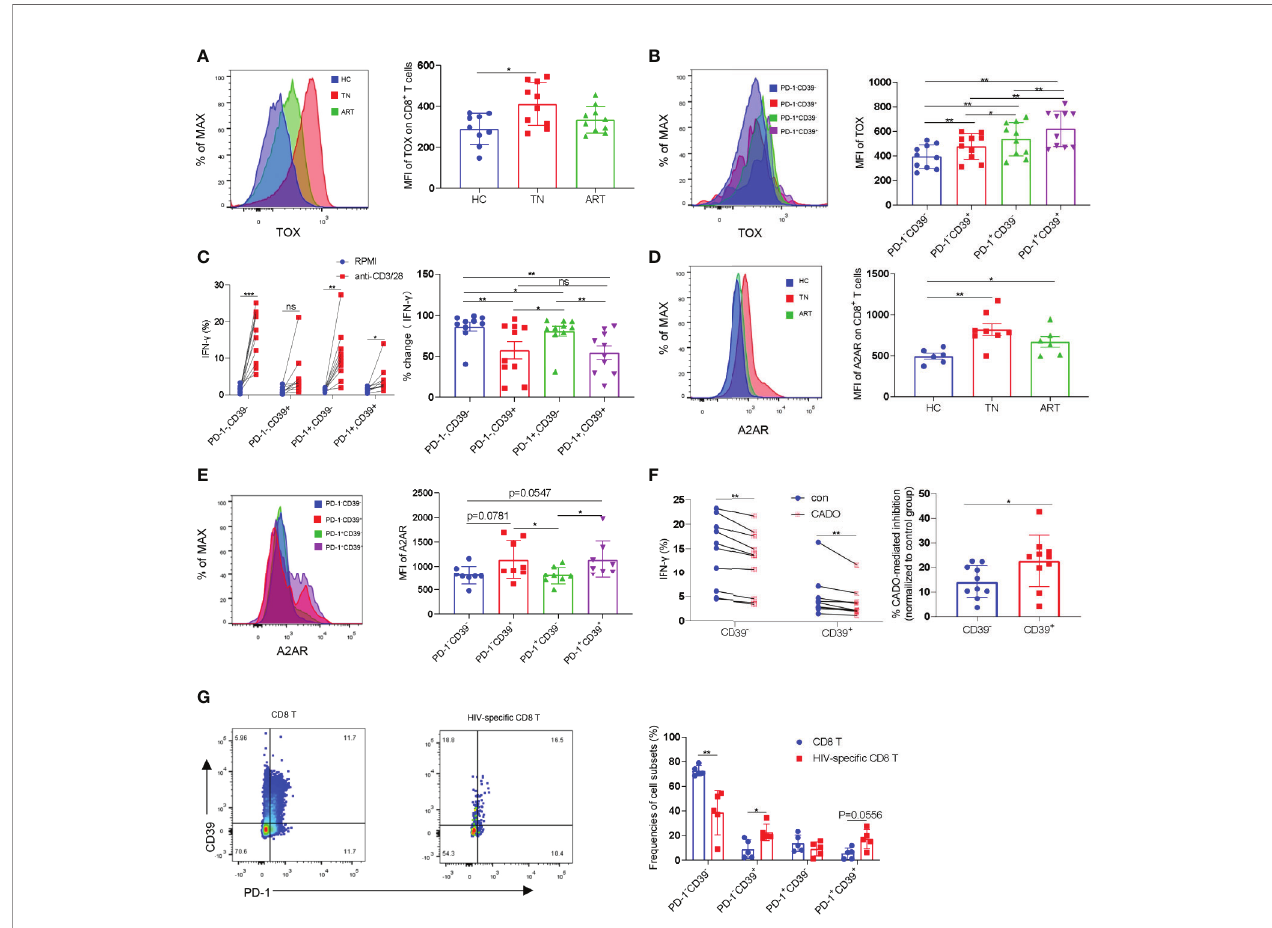
FIGURE 2 | CD39 + CD8 + T cells are highly exhausted and sensitive to CADO-mediated functional inhibition. (A) The expression levels of TOX in CD8 + T cells from HCs, TNs, and ARTs. (B) The expression levels of TOX in PD-1 - CD39 - , PD-1 - CD39 + , PD-1 + CD39 - and PD-1 + CD39 + CD8 + T cells from TNs. (C) PBMCs from TNs were stimulated with or without anti-CD3 and anti-CD28 monoclonal antibodies for 6 h. The fold changes in secretion of IFN- g by PD-1 - CD39 - , PD-1 - CD39 + , PD- 1 + CD39 - and PD-1 + CD39 + CD8 + T cells were assessed by fl ow cytometry. % fold change = (anti-CD3/28 treatment group-RPMI group)/anti-CD3/28 treatment group. (D) The expression levels of the A2A receptor on CD8 + T cells from HCs, TNs, and ARTs. (E) The expression levels of the A2A receptor in PD-1 - CD39 - , PD- 1 - CD39 + , PD-1 + CD39 - and PD-1 + CD39 + CD8 + T cells from TNs. (F) PBMCs from TNs were stimulated with anti-CD3 and anti-CD28 monoclonal antibodies for 6 h with or without CADO. The expressional levels of IFN- g by CD39 - and CD39 + CD8 + T cells were assessed by fl ow cytometry. The sensitivity to CADO medicated inhibition was compared between CD39 - and CD39 + CD8 + T cells by calculating fold changes. (% CADO-mediated inhibition = (CADO treatment group – anti-CD3/ 28 treatment group)/anti-CD3/28 treatment group). (G) Representative fl ow cytometry data for CD39 and PD-1 staining in total CD8 + T and HIV-speci fi c CD8 + T cells of TNs. The frequencies of PD-1 - CD39 - , PD-1 - CD39 + , PD-1 + CD39 - and PD-1 + CD39 + CD8 + T cells in total and HIV-speci fi c CD8 + T cells were assessed by fl ow cytometry. For statistical analyses, a Mann-Whitney U-test or a Wilcoxon matched-pairs signed rank test was performed, *p < 0.05, **p < 0.01, ***p < 0.001, ns, not signi fi